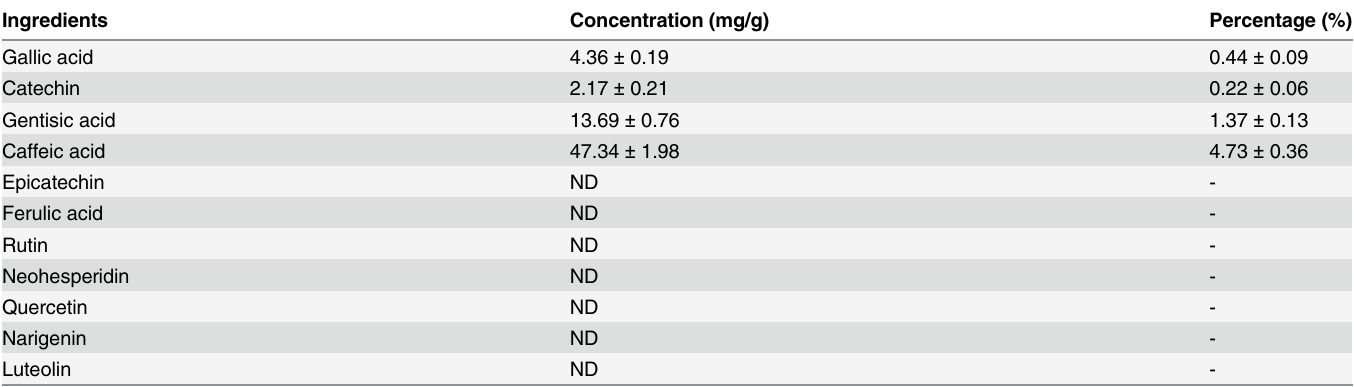
Table 1. Major components of phenolic acids and flavonoids in GM